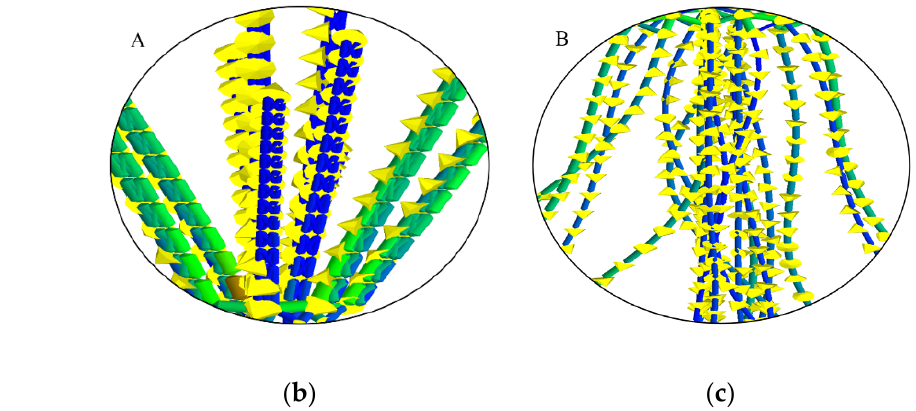
Figure 11. Flexible model of Cyperus esculentus plants. ( a ) Whole plant; ( b ) bonds between leaf particles; ( c ) bonds between root particles. Table 3. Contact parameters of discrete element model.